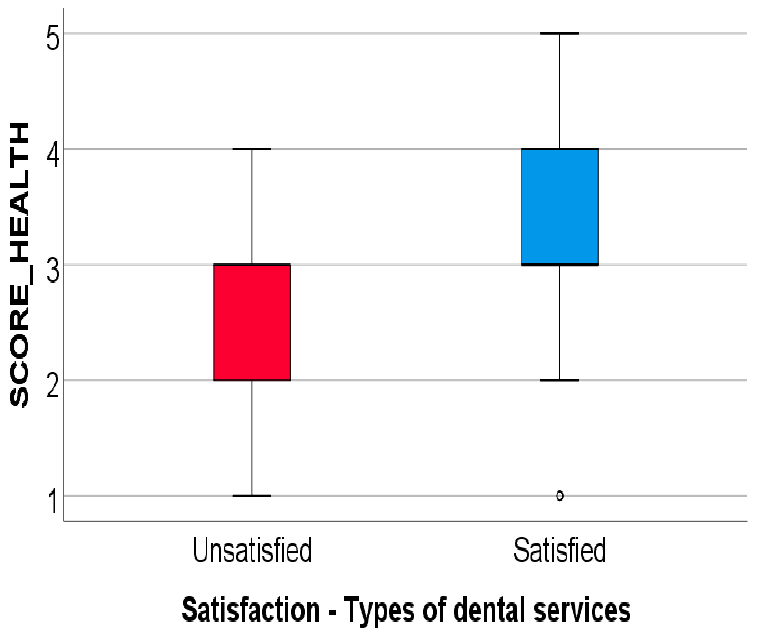
Figure 1. Comparison of oral health score between answers according to satisfaction about the types of covered dental services. In the boxplot figure, the dot ( ◦ ) represented above the “Satisfied” text, represents a value which SPSS considers a potential outlier. In this case the value represents a low potential outlier (a value which was more than1.5 IQR but at most 3 IQR below quartile 1 of the represented score). Int. J. Environ. Res. Public Health 2022 , 19 , x FOR PEER REVIEW